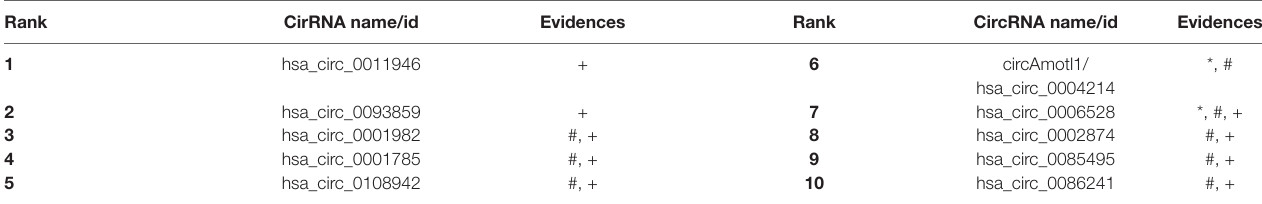
TABLE 4 | The top 10 breast cancer–related candidates’